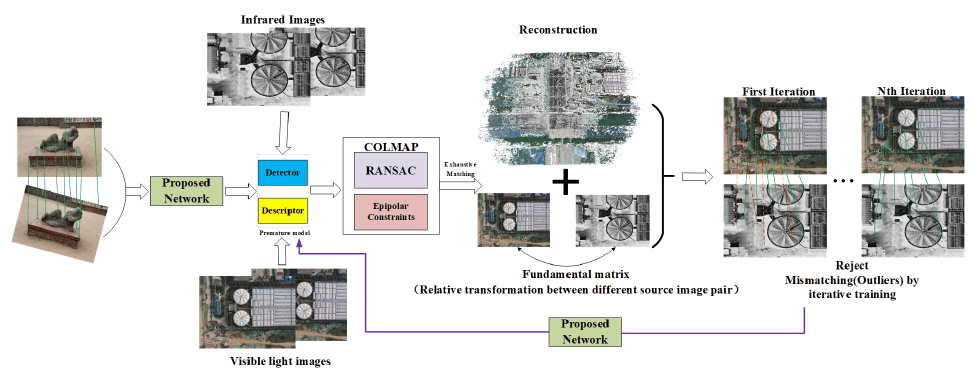
Figure 8. The proposed training pipeline. Algorithm 1 Train stage 1: Self-labelled local feature detector and descriptor model trained on visible light